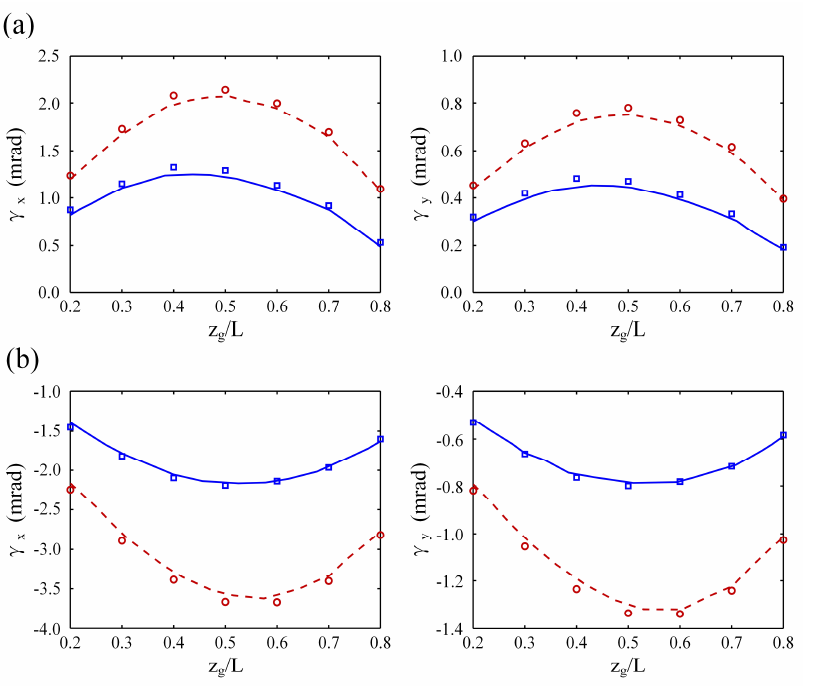
Figure 8. The comparison of the bearing angular displacements. ds = 35 mm, ds = 40 mm from Tong’s model and ds = 35 mm, ds = 40 mm from the present system model. ( a ) Face-to-Face arrangement; ( b ) Back-to-Back arrangement.